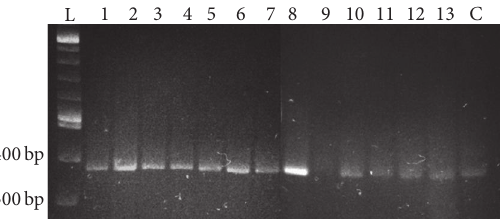
Figure 5: PCR study of SERT promoter length polymorphism shows the uniform presence of the long allele in 13 ACD/MVP patients (1–13); L is the DNA ladder and C is the amplicon from a control